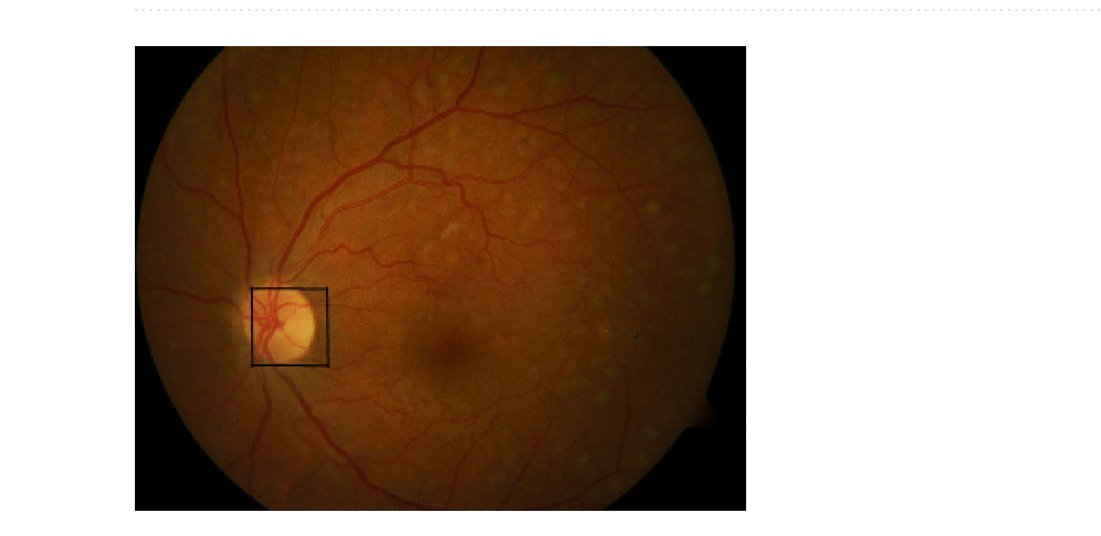
Figure 6. A fundus image and its localized optic